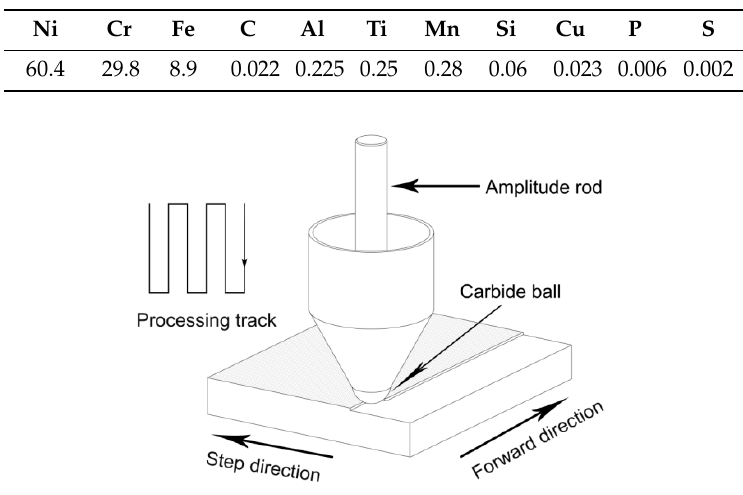
Figure 1. The simulation of the machining process.